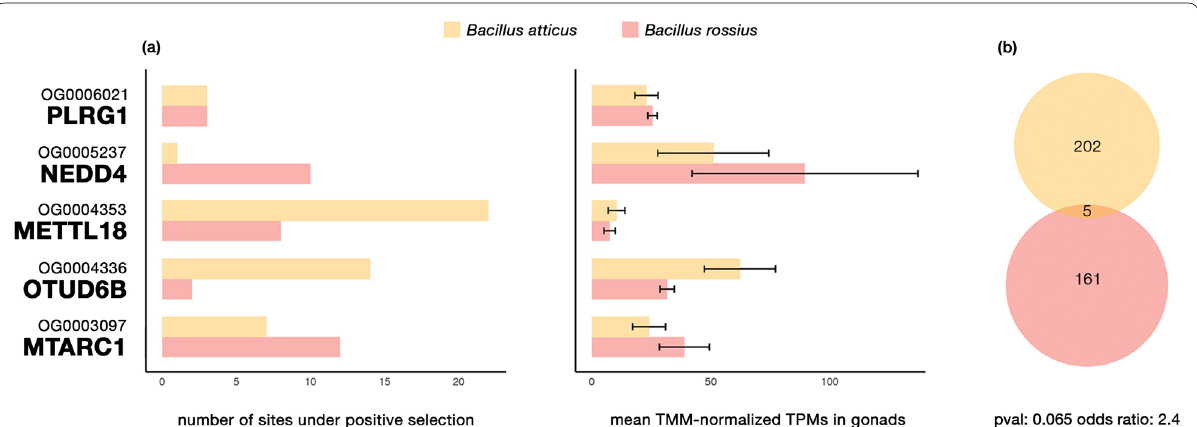
Fig. 6 Parallel instances of positive selection: a on the left, number of sites inferred to have undergone positive selection (BEB > 95) in the two parthenogens; on the right, TMM-normalized expression values for the same genes. Genes with < 10 TPMs in parthenogen gonads were not considered. On the y axis, the orthogroups in which the genes are found, and the putative homologs (in bold) are given. b Venn-diagrams representation of the shared changes across the two parthenogens, for which Fisher’s exact test has been used to determine p and odds ratio in comparison to the genomic background ( n =